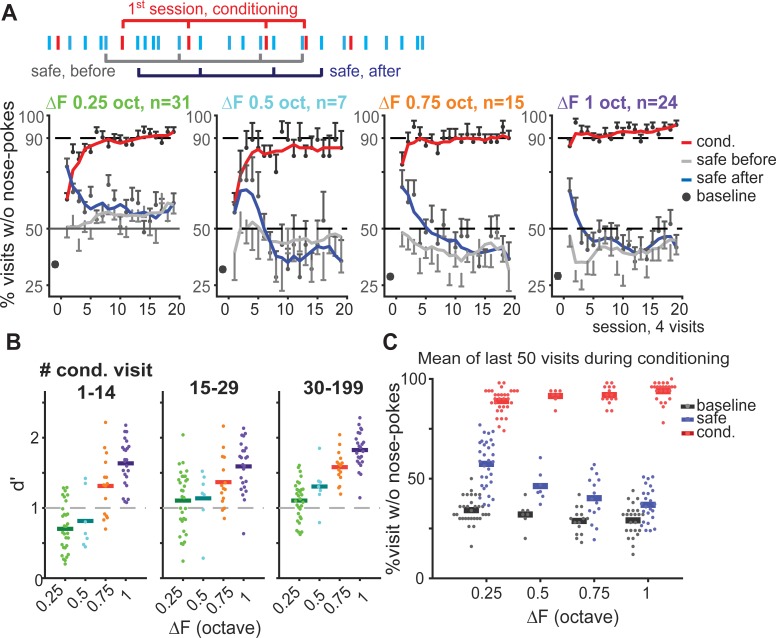
Discrimination performance deteriorated as the safe-to-conditioned ΔF decreased.(A) Top: Schema of learning curve analysis in sessions: average of blocks of 4 visits starting after the first conditioned visit (red) separately for safe visits (blue) that follow conditioned visits (blue brackets), safe visits that precede conditioned visits (gray brackets), and conditioned visits (black brackets). Bottom: performance analysis pooled across groups trained with same safe-to-conditioned ΔF, (ΔF 0.5 group, 1 replication only). Baseline performance (black dot) calculated as the mean response over the last 50 safe visits before the first conditioned visit. Mean performance in each session was plotted using a smoothed learning curve (5 moving average filter) for safe visits following conditioned visits (dark blue), safe visits preceding conditioned visits (gray), and conditioned visits (red). Non-smoothed data points are shown in the background as half error bars in different shades of gray. (B) d’ calculated as a function of the ΔF for conditioned visits number 1–14 (left), 15–29 (middle) and 30–199 (right) starting after the first conditioned visit. (C) Mean responses to the safe (blue) and conditioned (red) tones during the last 50 conditioned visits in the conditioning phase across groups trained with different ΔFs. Baseline (black) was calculated the same as (A). Here and in subsequent figures, dots in scatter plots represent result for an individual mouse and horizontal bars describe average across animals.